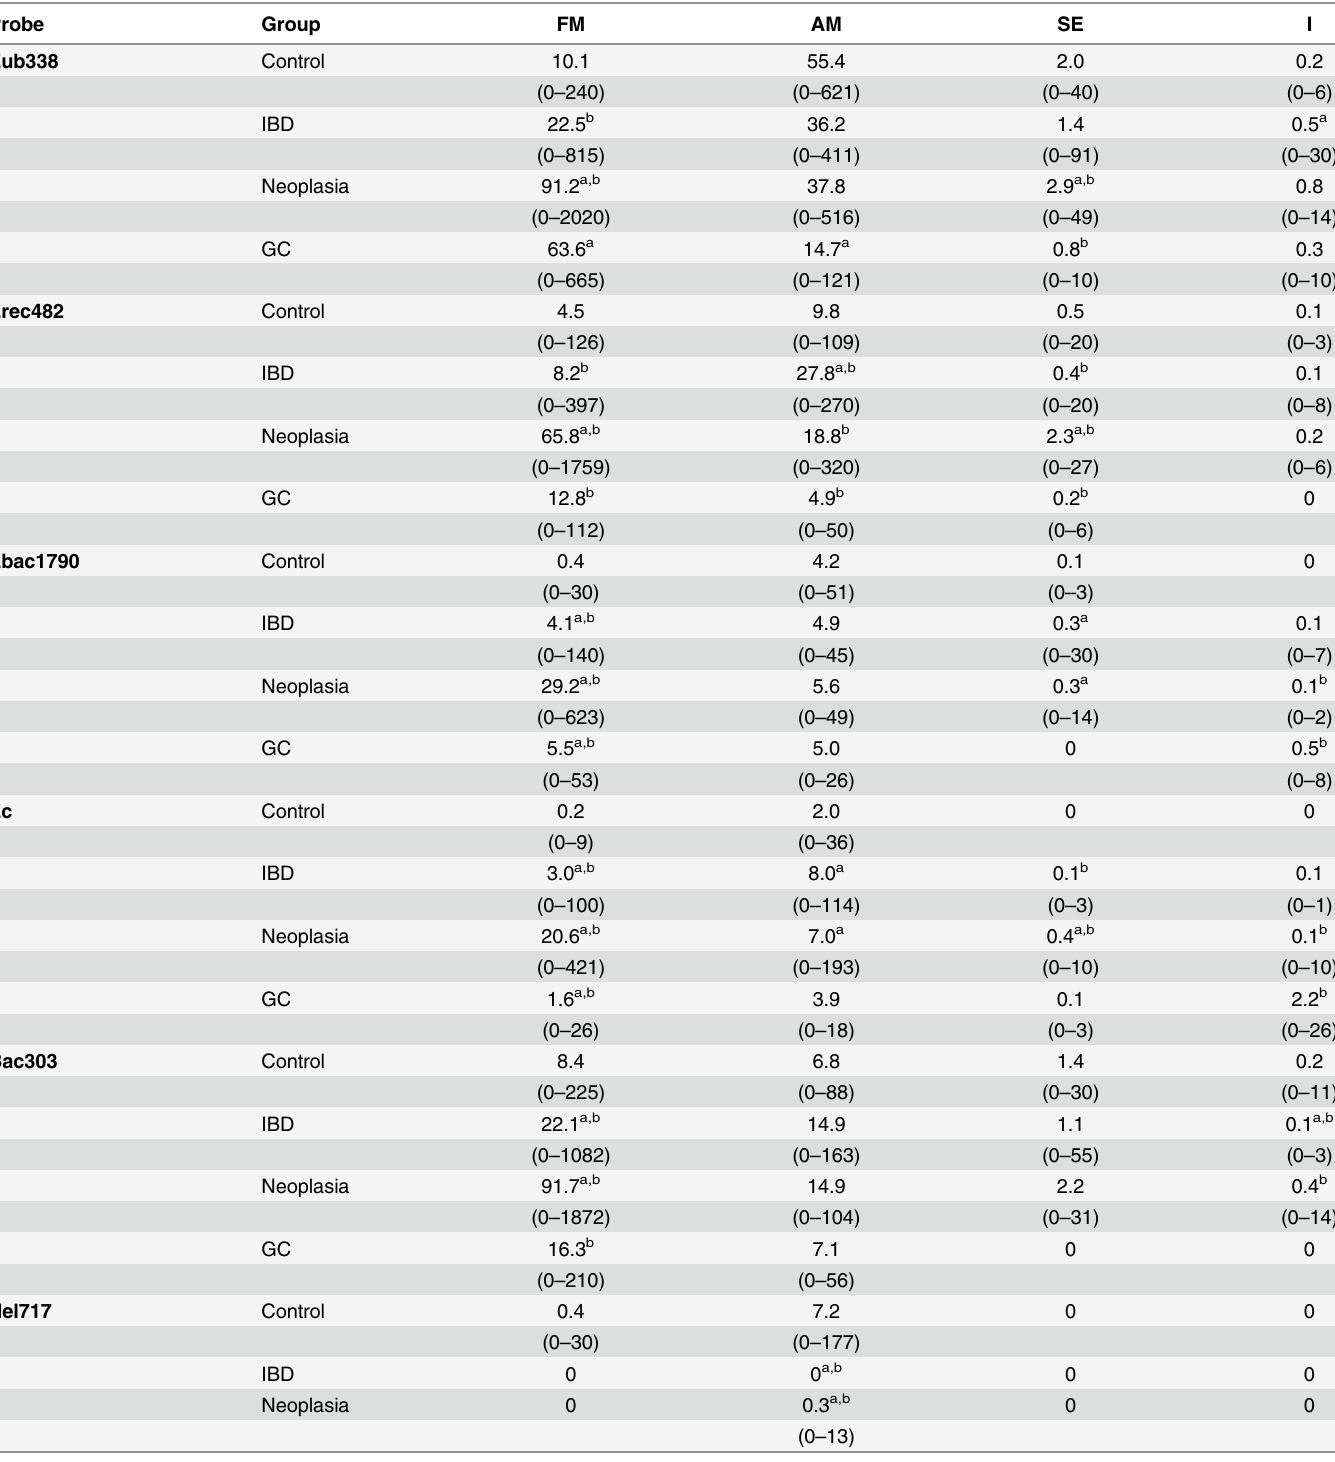
Table 7. Spatial distribution of the number of colonic bacteria based on